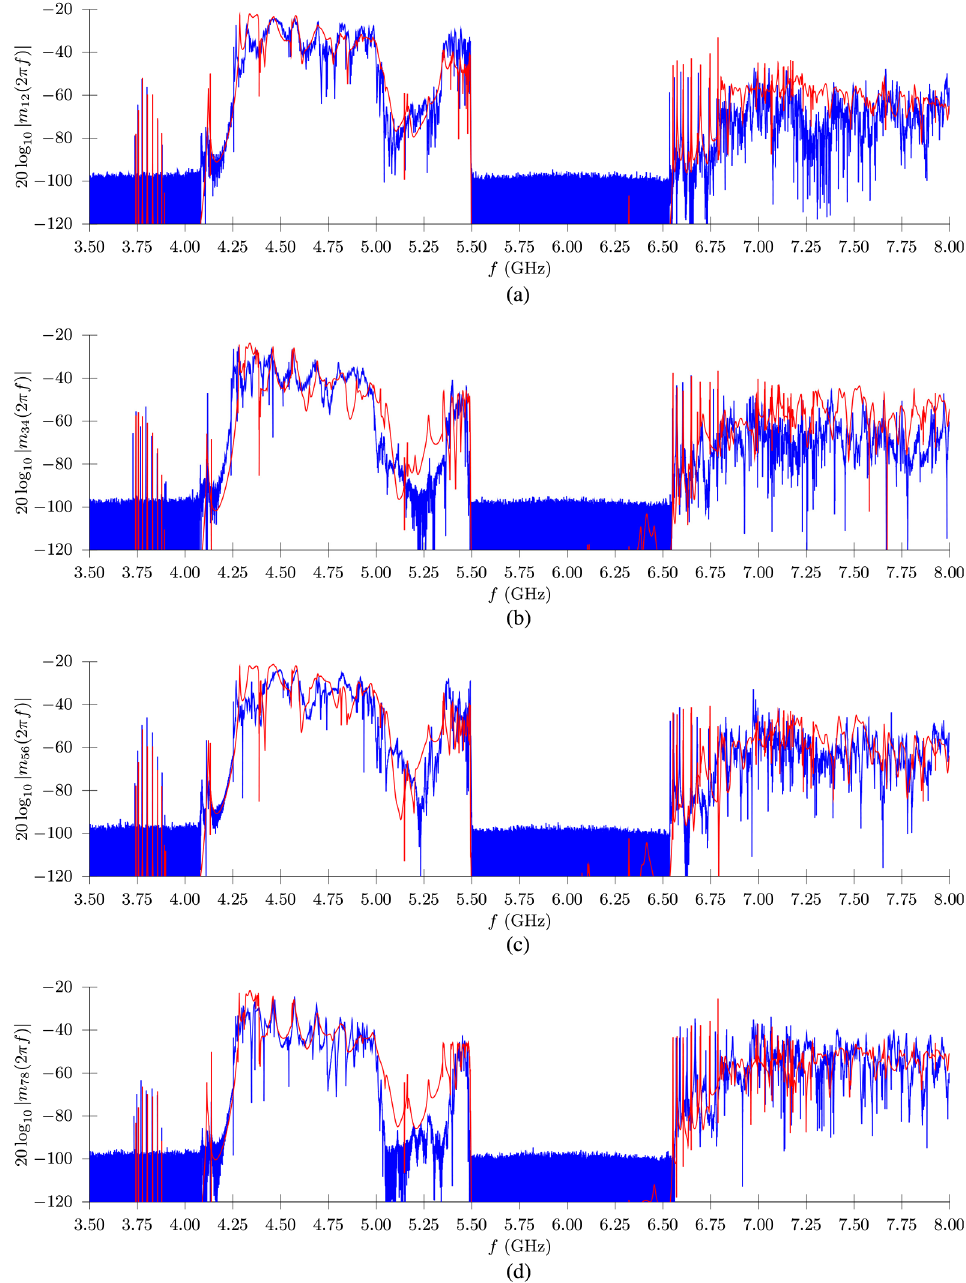
FIG. 11. Comparison between measured (blue) and simulated (red) absolute value of the HOM coupler to HOM coupler transmission through each of the four cavities embedded in the chain. The indices of the scattering parameters m (see ordinate labeling) refer to the jk port nomenclature presented in Fig. 2(a). All plots show basically similar characteristics: The peaks of the fundamental TM monopole bands are visible in the interval from 3.72 to 3.92 GHz. The first two TE dipole bands are shown in the region from 4.25 to 5.50 GHz. In the interval from 5.50 to 6.55 GHz a stopband is located. The sharp peaks in the interval 6.55 to 6.75 GHz are assumed to belong to the quadrupole band. In contrast to the simulated data, the measured data shows a noise floor at − 100 couplers presented in [9] (page 19, Table 3). The measured quality factors reflect external (energy losses via waveguide nodes. The quality factors in Fig. 12 indicate the simulations ports) and intrinsic losses (energy losses due to finite surface and experimental results agree to within an order of magni- resistivity), whereas in the simulated Q-factors by tude. Furthermore,the quality factors are in the same order as assumption only external losses are considered. However, the quality factors for a single third harmonic cavity with